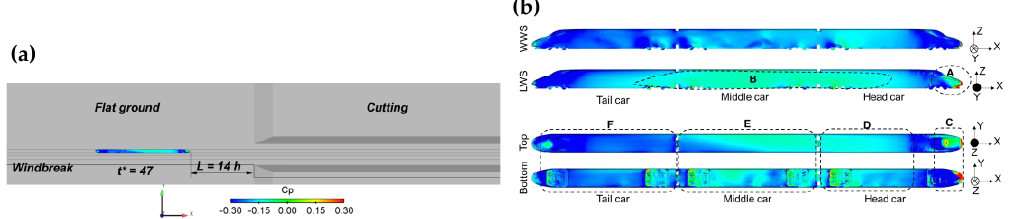
Figure 8. Pressure distribution on the train surface at t * = 47: ( a ) train position and ( b ) pressure distribution.